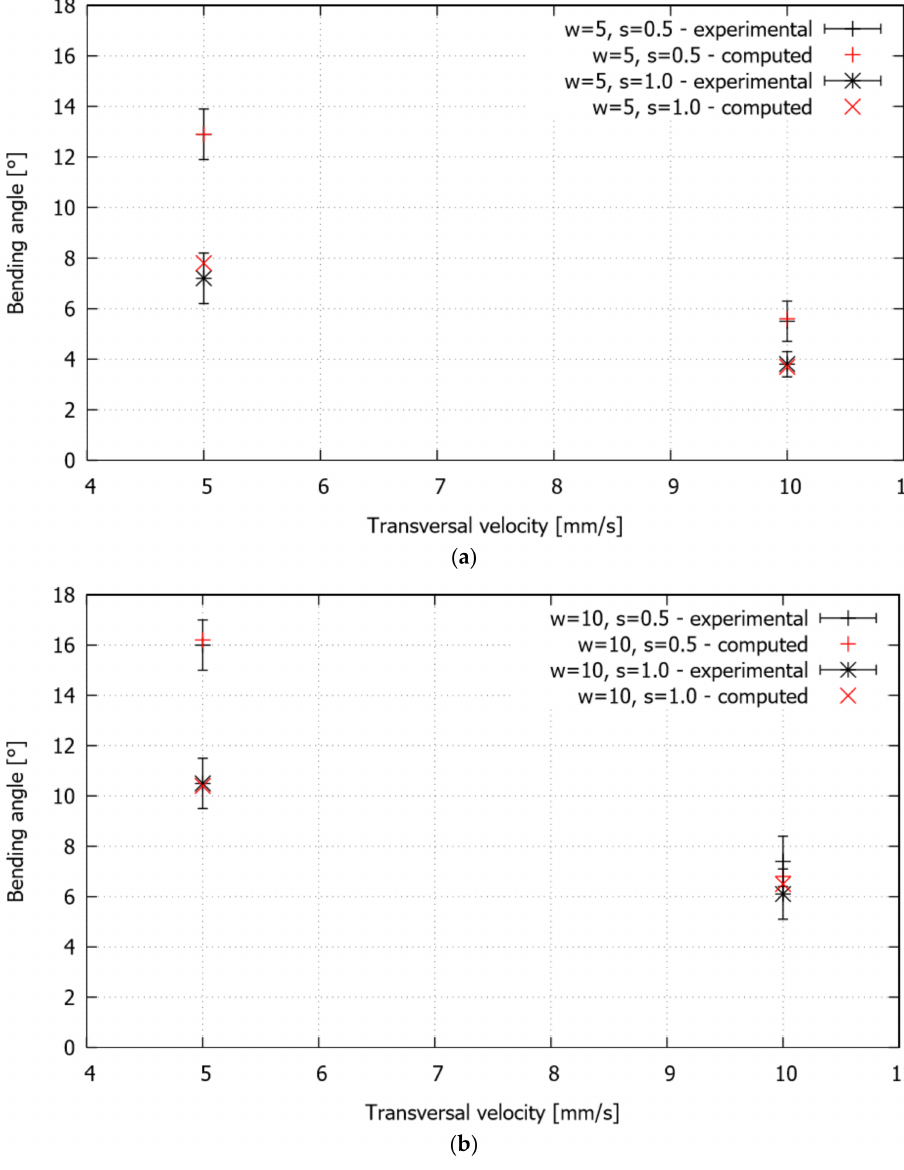
Figure 8. Single S-shape scanning path. Final bending angle for the studied cases: ( a ) w = 5 mm, ( b ) w = 10